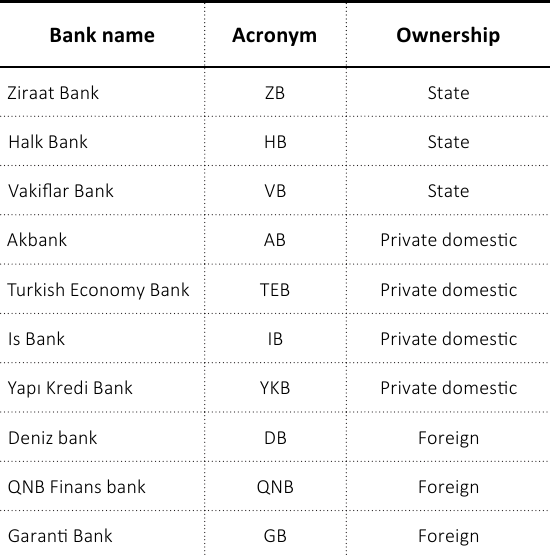
Table 1. Turkish banks included in the